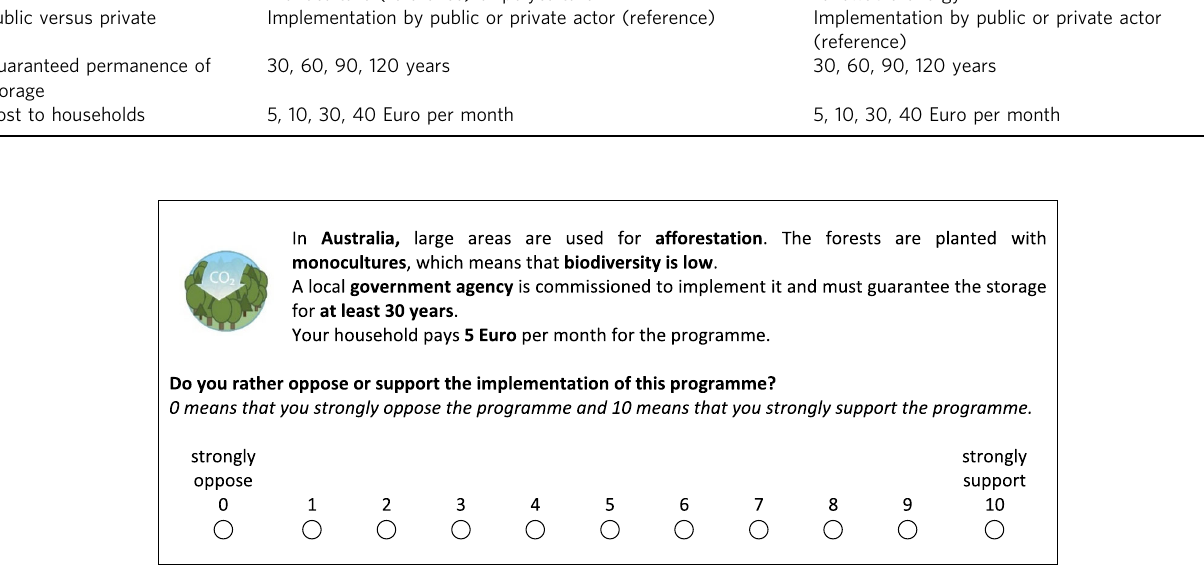
Fig. 1 Respondents saw 3 vignettes for afforestation. The parts of the explanation printed in bold took different levels as presented in Table 1.